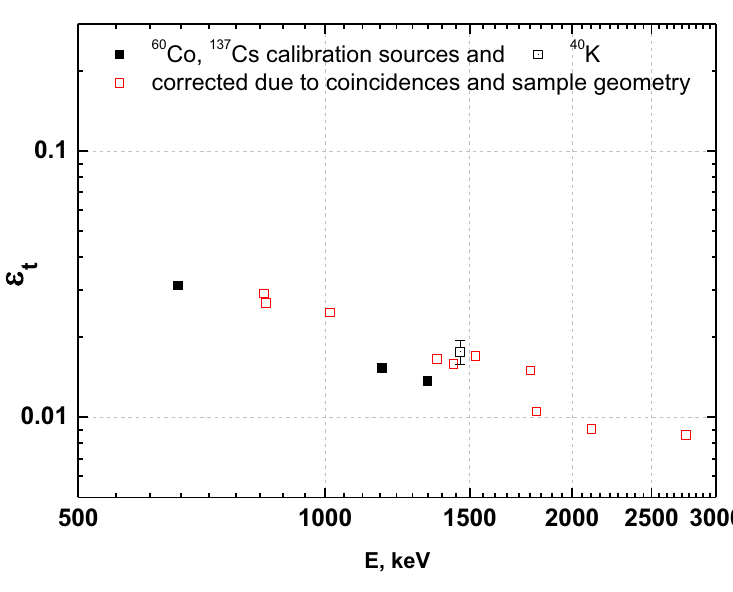
Figure 3. HPGe detector registration efficiency factors for each of the neutron activation products (see also Table I for